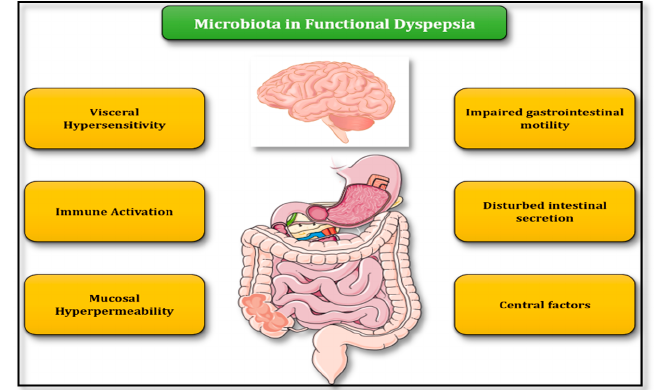
Figure 1. Putative mechanisms of gut microbiota involvement in FD pathogenesis.